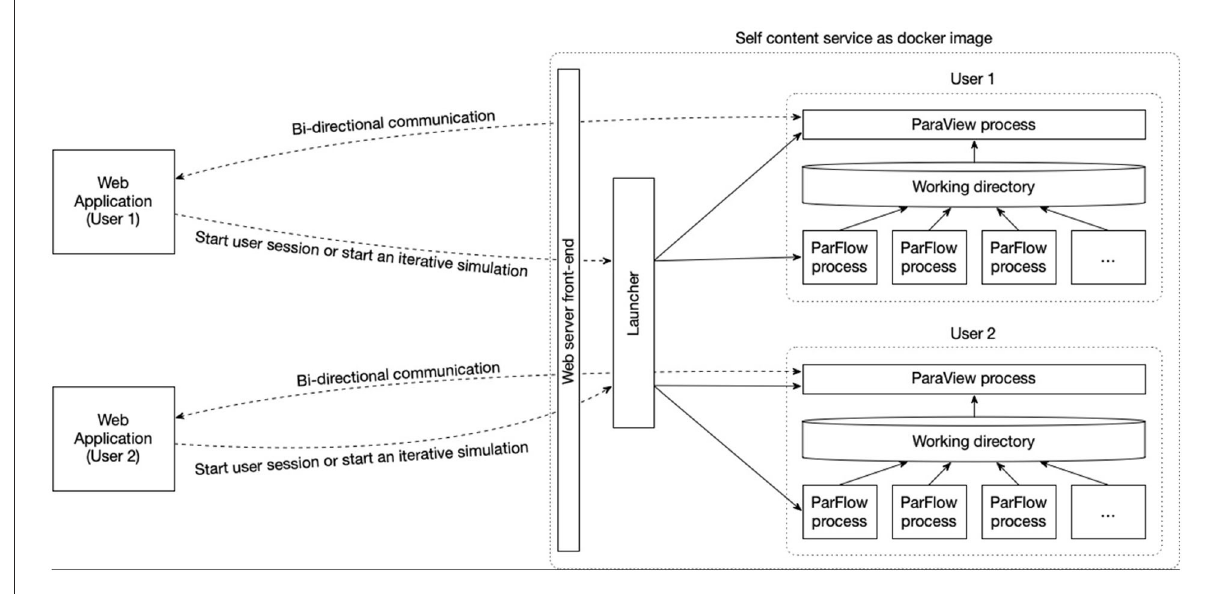
FIGURE5 Communication pattern of the ParFlow Sandtank